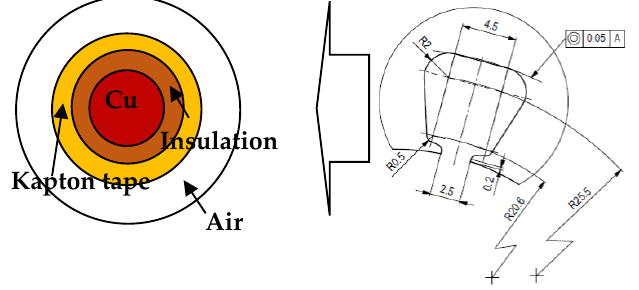
Figure 11. Scheme of homogenization of the stator slot with geometrical dimensions.